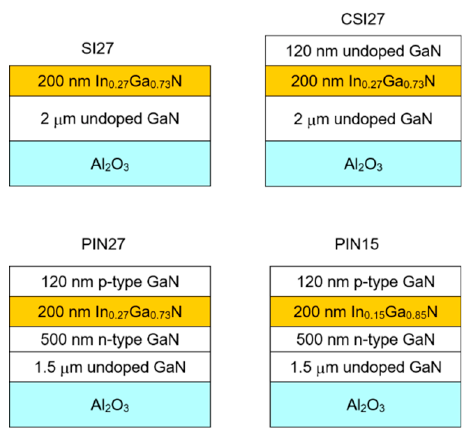
Figure 1. Scheme of InGaN/GaN sample structures used in this work.